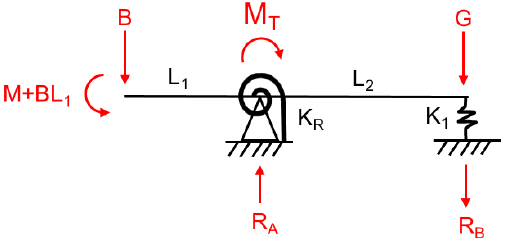
Figure 13. Force balance model for the whole system.